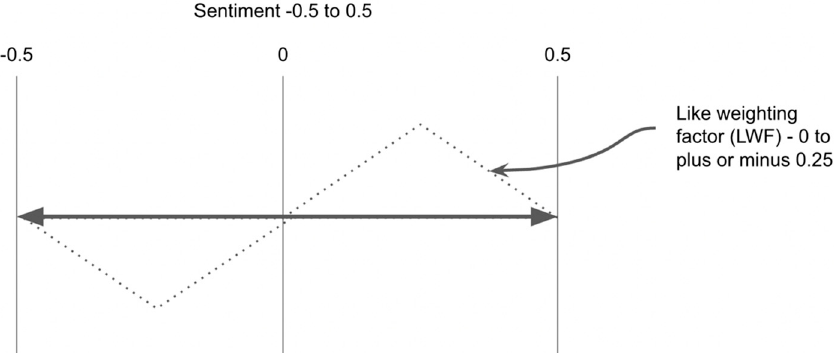
Figure 12. Like Weighting factor.